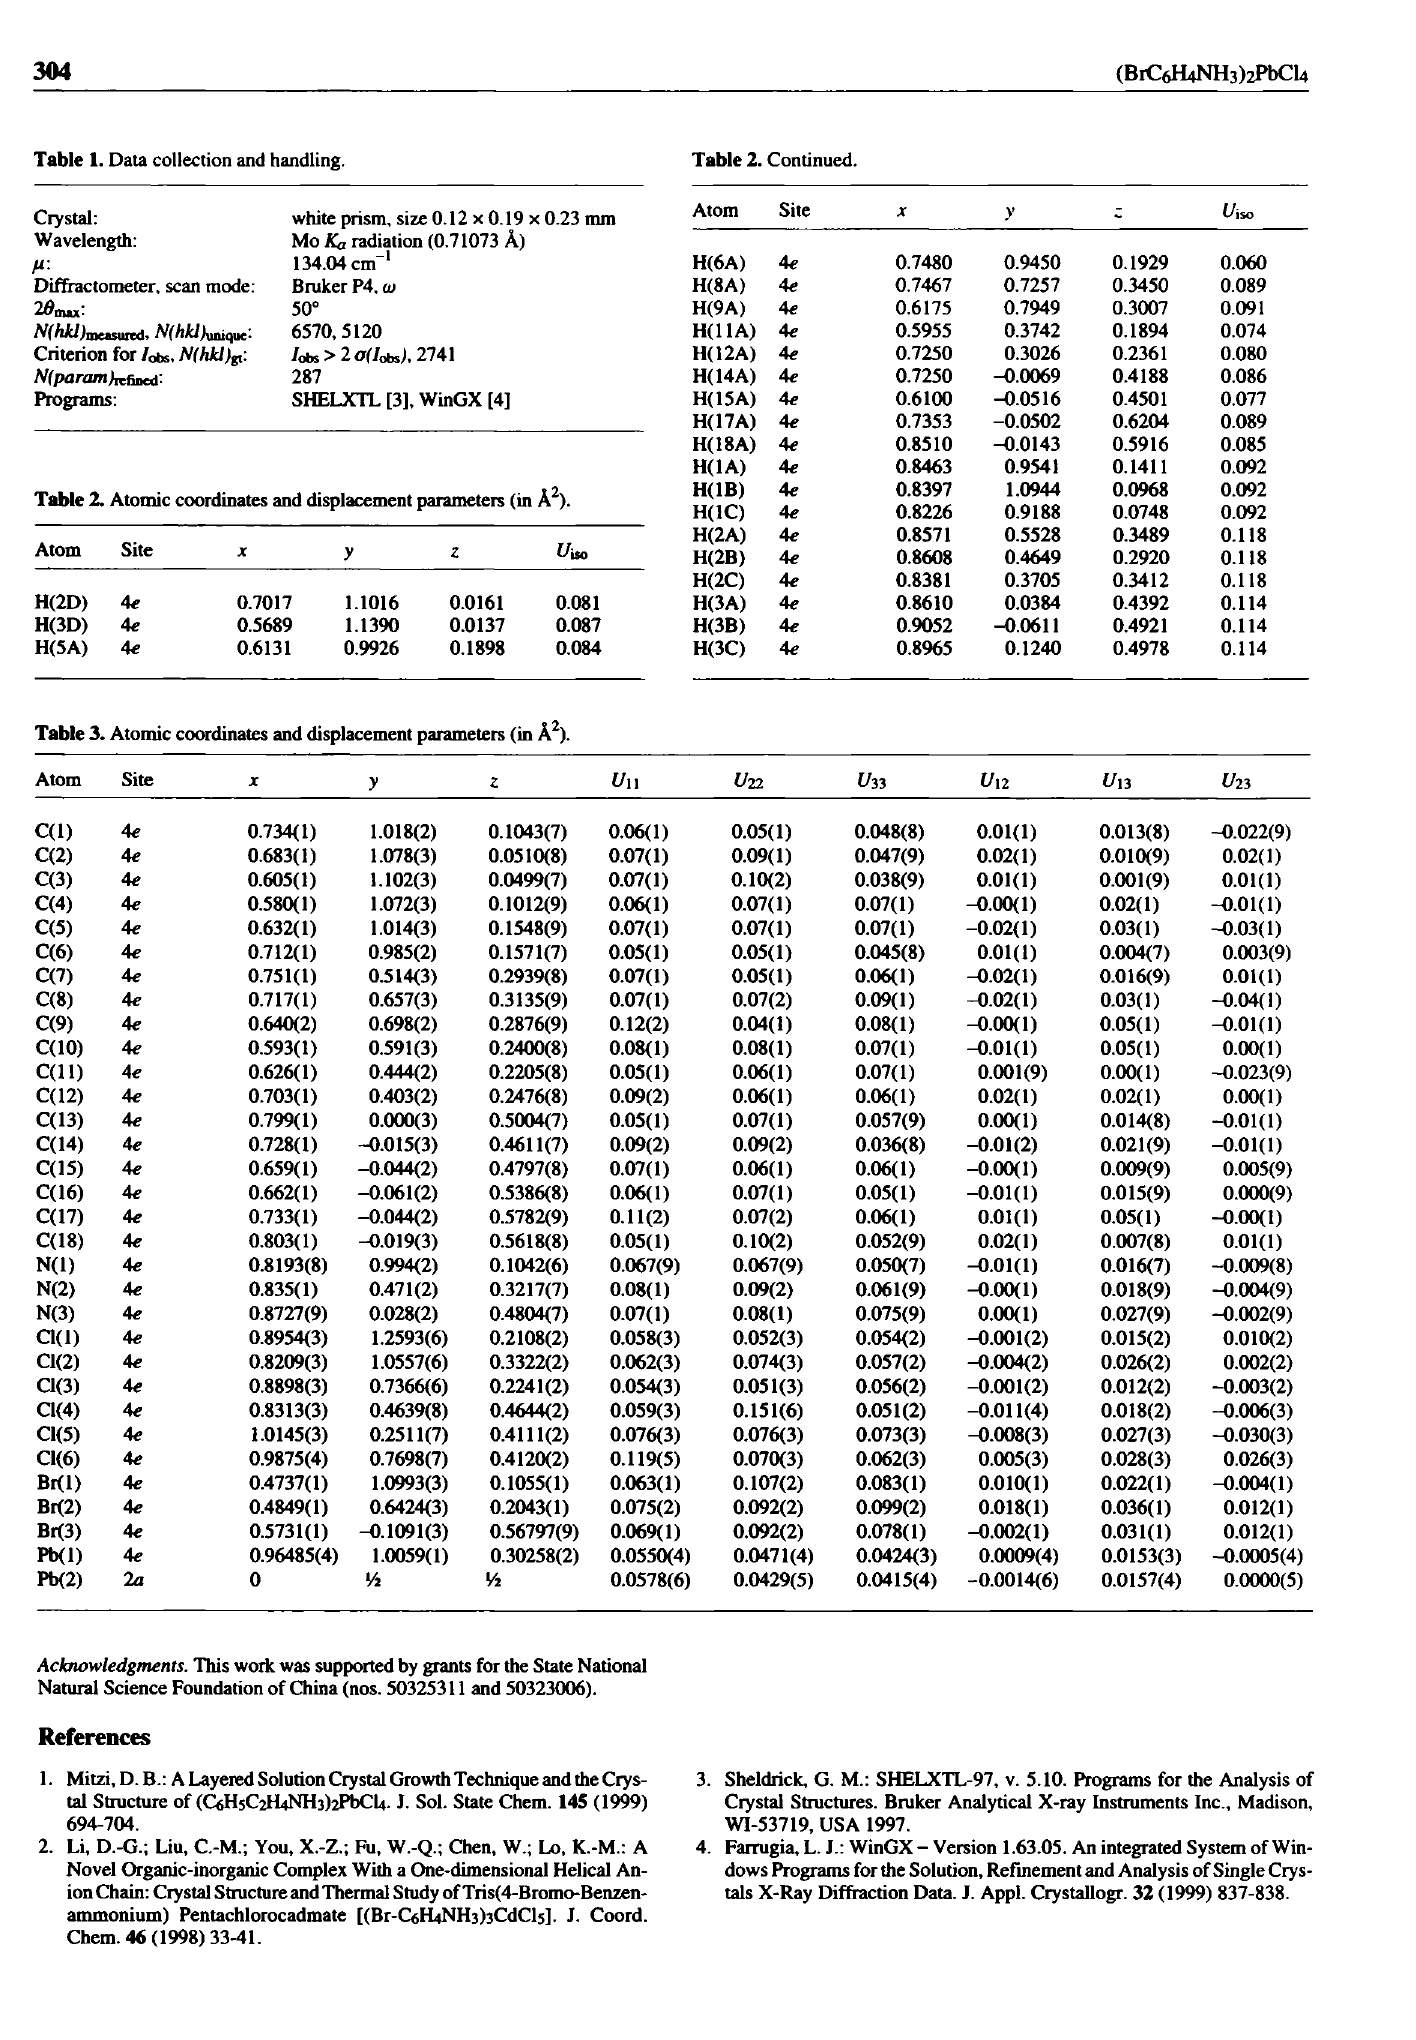
Table 1. Data collection and handling.